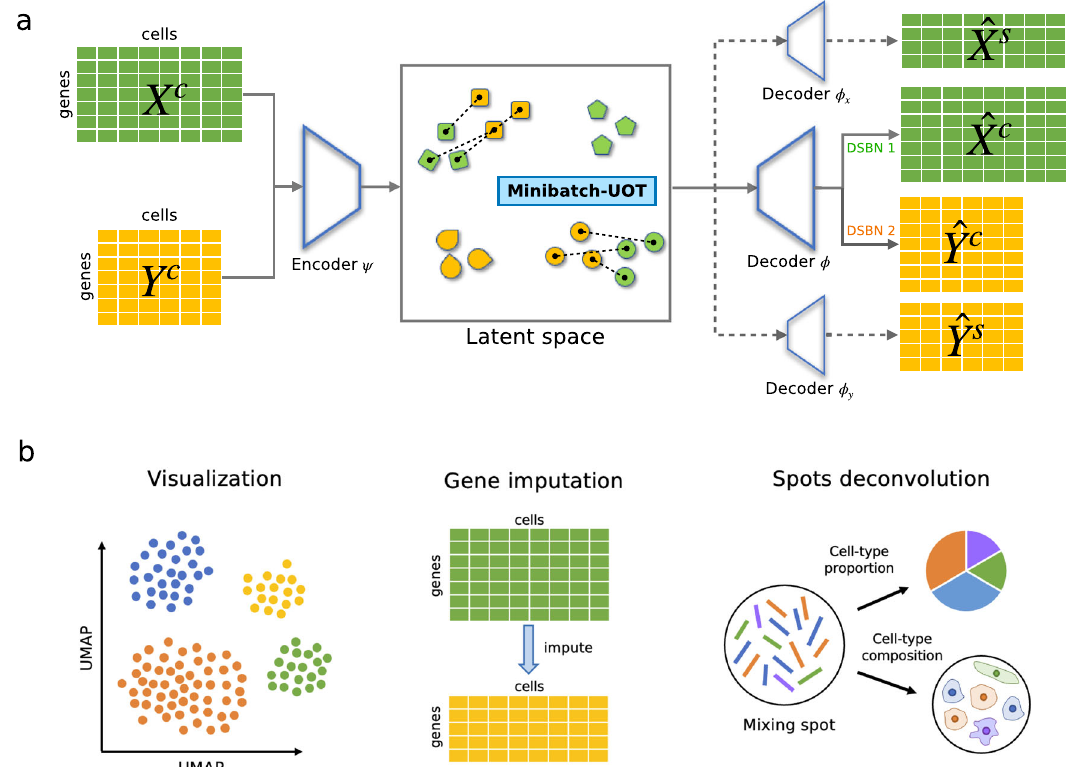
Fig. 1 | Overview of uniPort algorithm. uniPort integrates single-cell data by combining a coupled-VAE and Minibatch-UOT. uniPort takes as input a highly variable common gene set of single-cell datasets across different modalities or technologies. a uniPort projects input datasets into a cell-embedding latent space through a shared probabilistic encoder. Then uniPort minimizes a Minibatch-UOT loss between cell embeddings across different datasets. Finally, uniPort